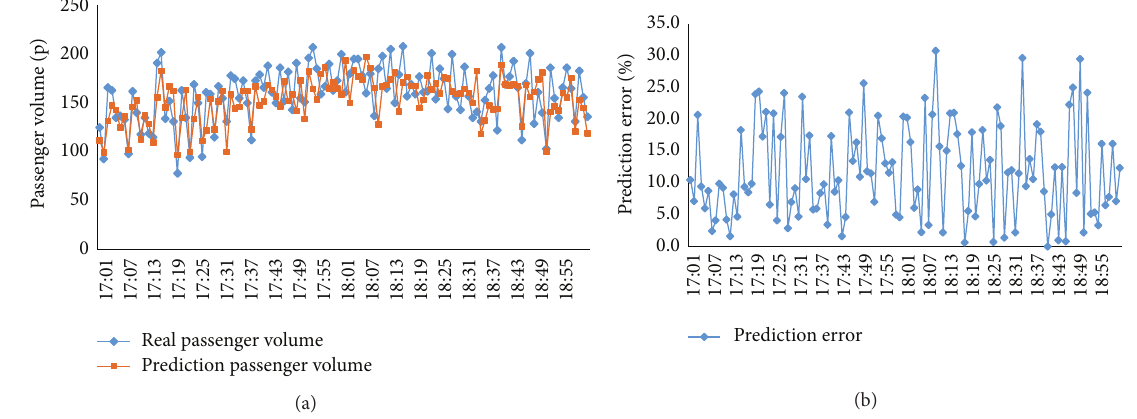
Figure 9: Forecasting the result for each 1 minute in evening peak hour using nonparametric regression.